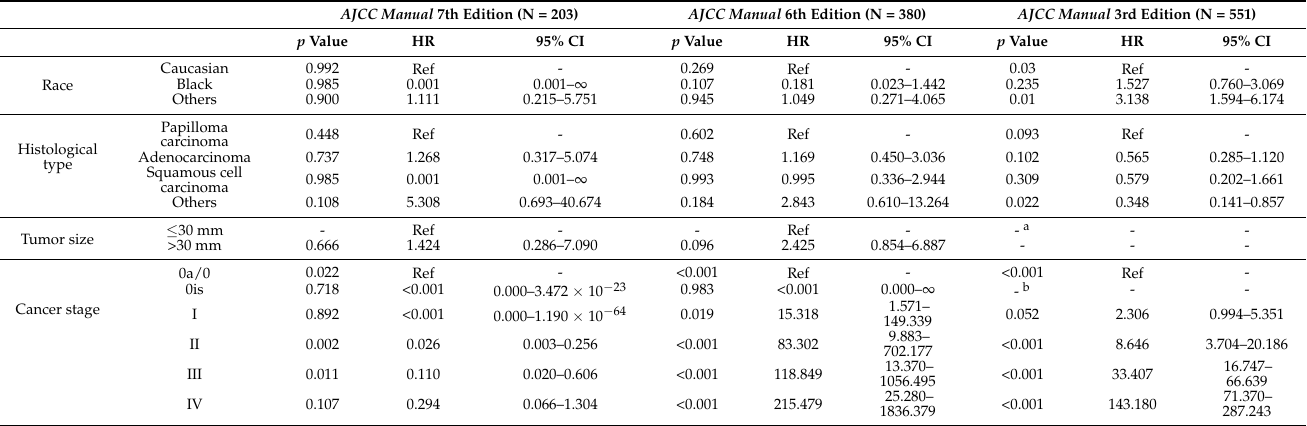
Table 2. Multivariate Cox regression predicting cancer-specific survival-based AJCC